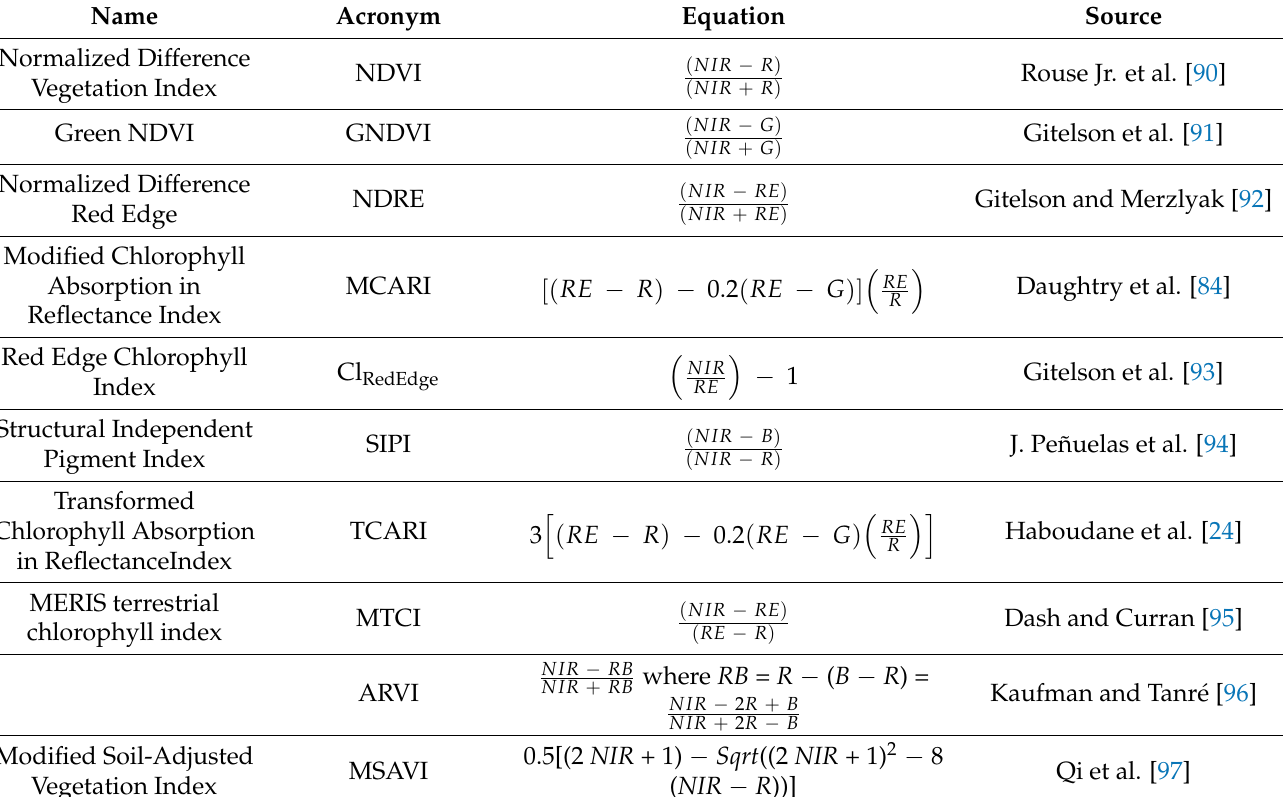
Table A1. A. Vegetation Indices calculated from Tetracam macaw bands: B = Blue; G = Green; C = Cyan; R = Red; RE = Red Edge; NIR = Near